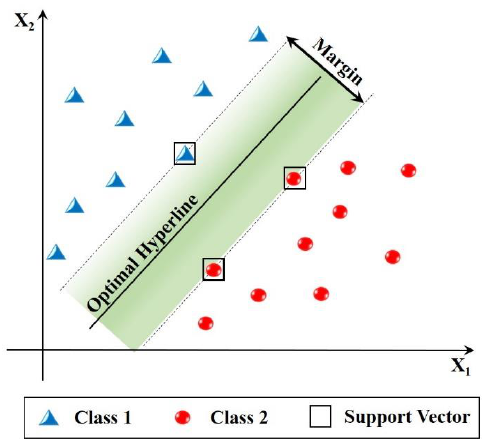
Figure 15. The structure of support vector